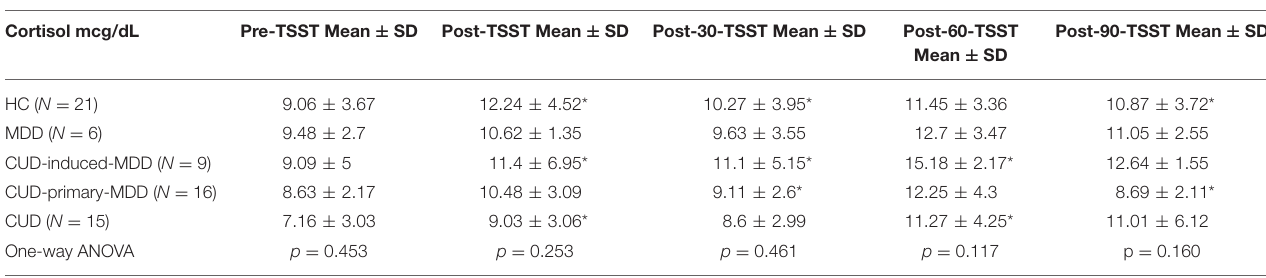
TABLE 2 | Mean cortisol concentrations during Trier social stress test